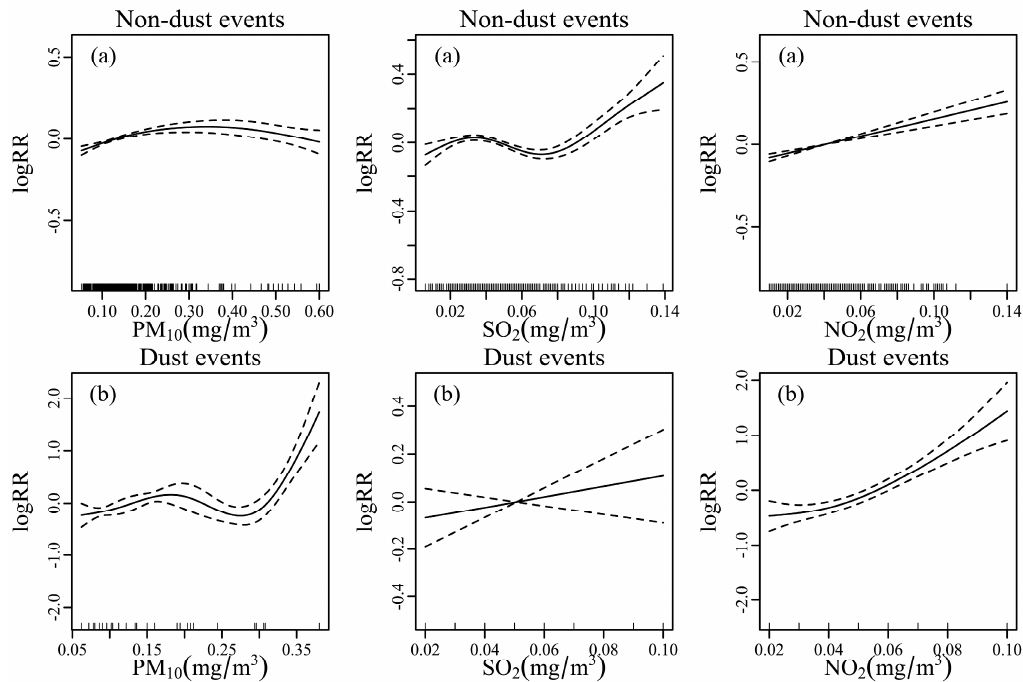
Figure 2. Smoothing plots of air pollutant concentrations against ER visits risk of respiratory under non-dust days ( a ) and dust days ( b ) for PM 10 ( left ), SO 2 ( center ), and NO 2 ( right ). X-axis is the pollutant concentration (mg/m 3 ). The solid lines indicate the log RR of ER visits, and the dotted lines represent 95% confidence intervals. Single day lags (L7 for PM 10 and SO 2 , L2 for NO 2 ) were used on non-dust days. Single day lags (L3 for PM 10 , L5 for SO 2 and NO 2 ) were used on dust days. All models were controlled for time trend, DOW, holiday and weather conditions.